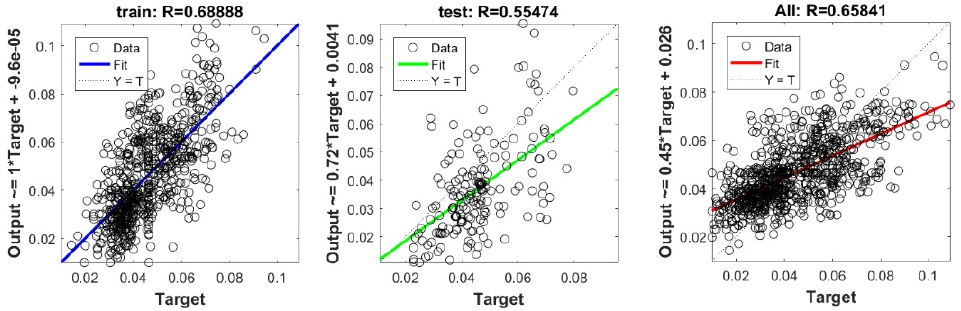
Figure A4. Scatter plots between target and output value by the FS-GP model.